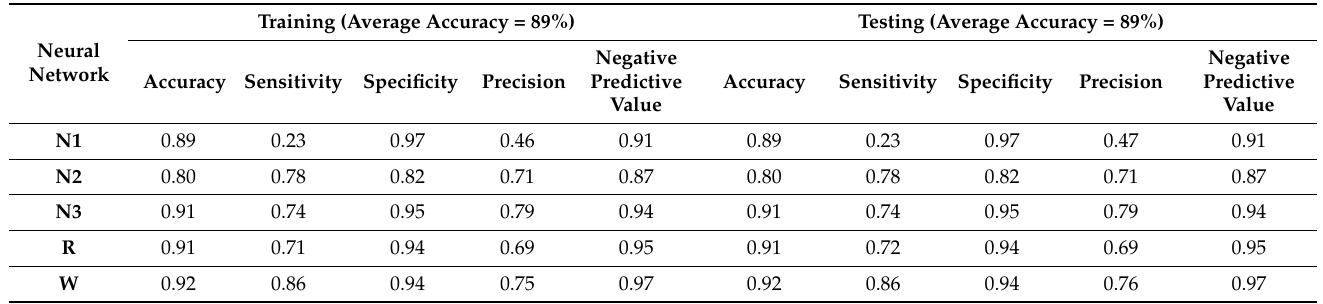
Table 8. Confusion matrix of the Neural Network Model using training and testing datasets for the classification of EEG features of the sleep stages W, N1, N2, N-3, and R.